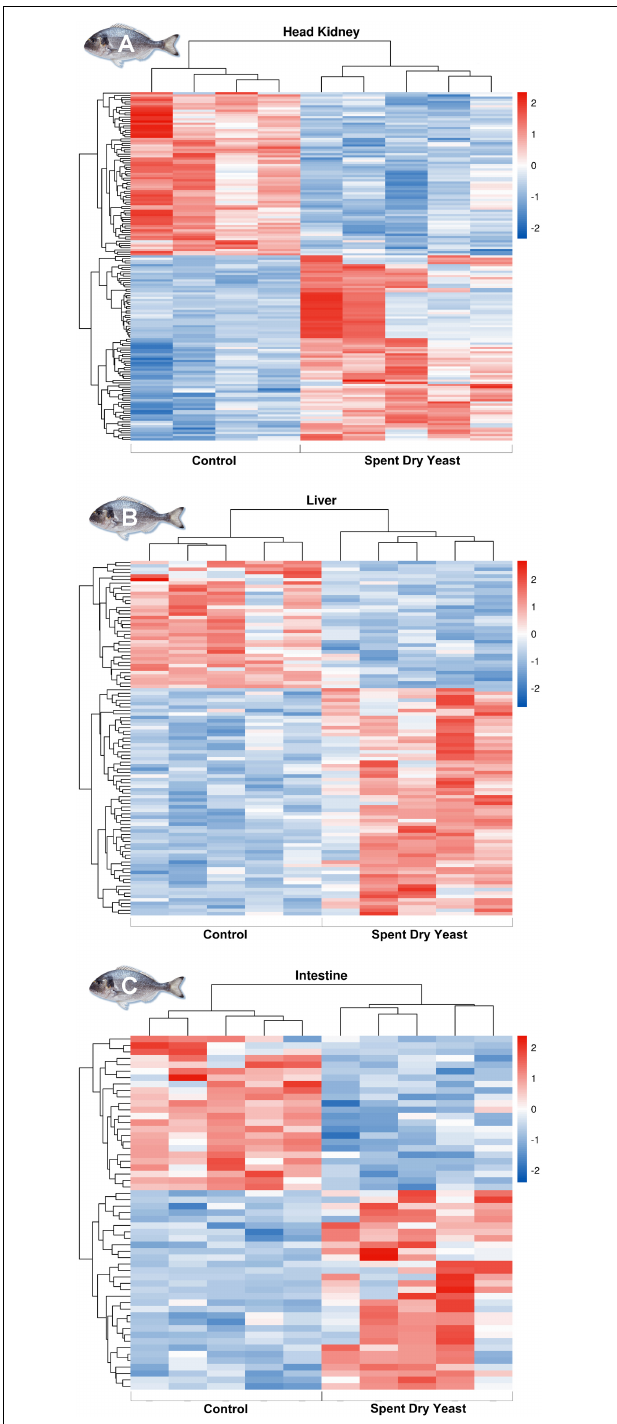
FIGURE 2 | Hierarchical clustering of transcriptomic response from the head kidney (A) , liver (B) , and anterior-mid intestine (C) of gilthead seabream ( Sparus aurata ) fed the control and the Brewer’s SDY diets. This heat map is based on similitude patterns of the differentially expressed genes from five replicates per tissue both dietary groups with the only exception of the head kidney where one replicate from the control group was excluded from the analysis as shown in Supplementary Figure 1 (results from the Principal Component